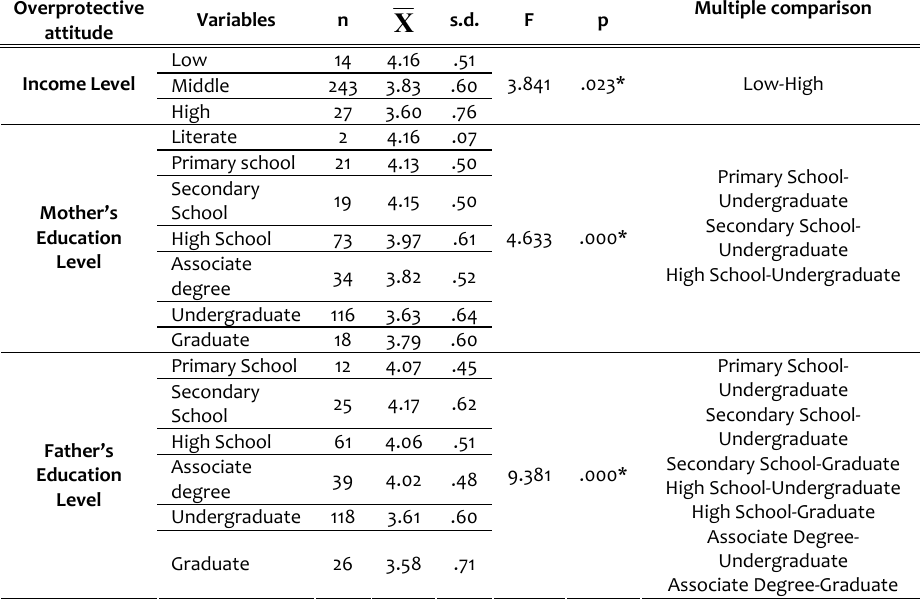
Table 7 . Results of ANOVA test related to the overprotective attitude and income level